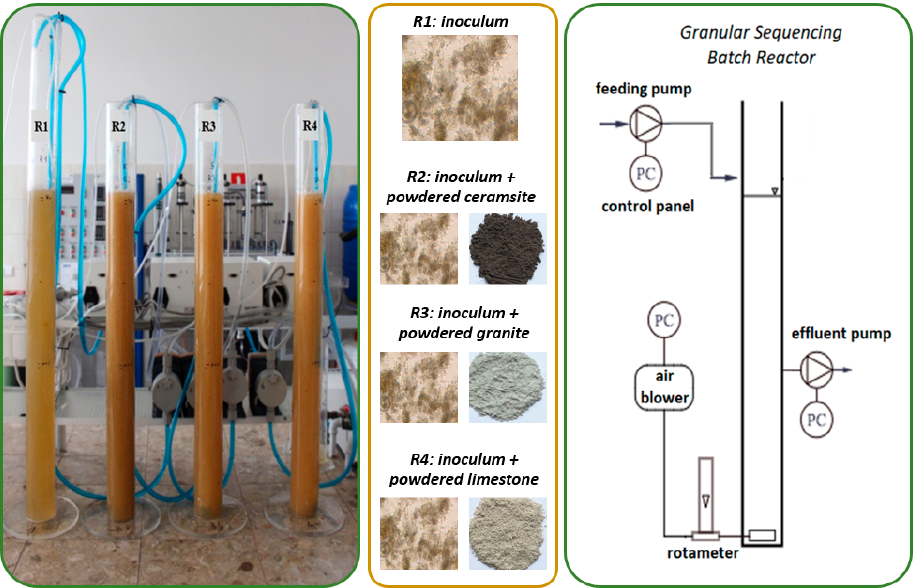
Figure 6. The test Figure 6. The test system. Table 4. Characteristics of powdered mineral materials.